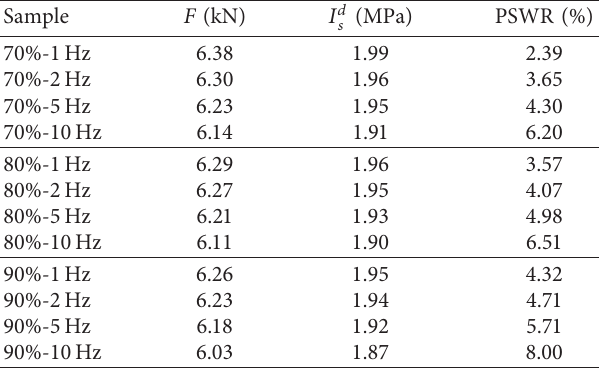
Table 3: The point load strength of prestatically loaded marble subjected to dynamic